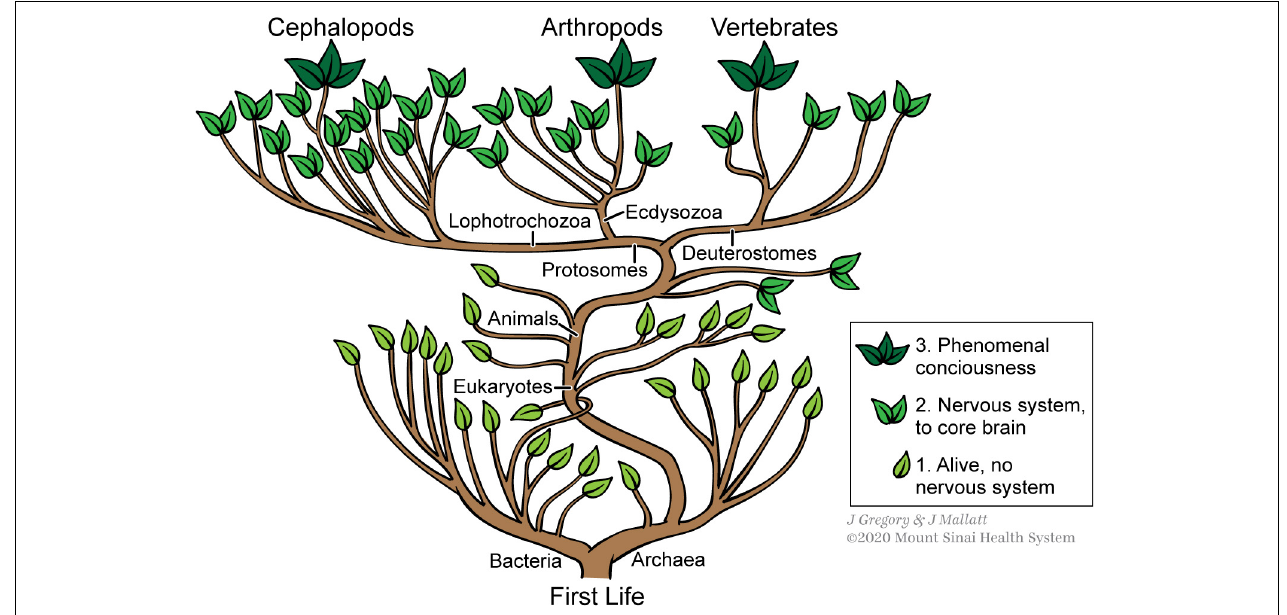
FIGURE 4 | The phylogenetic “bush of life” showing that consciousness (as three-leaved stems) emerged independently in three different lines of animals. Figure © Mount Sinai School of Medicine.